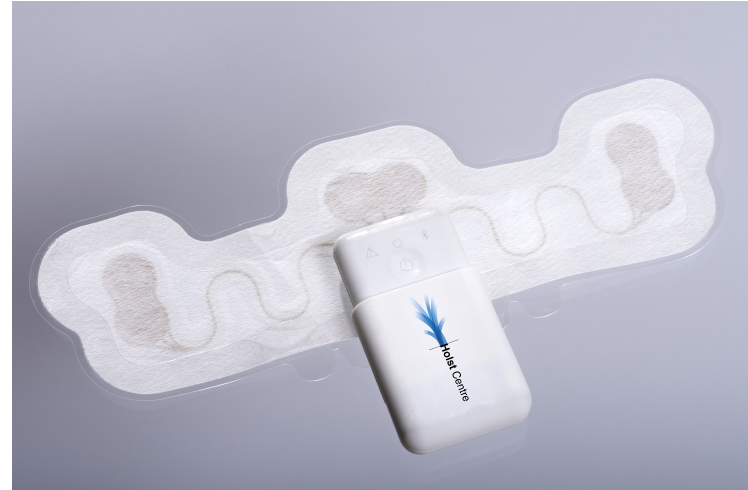
Figure 1. Single-lead Vital Signs patch exploded view.